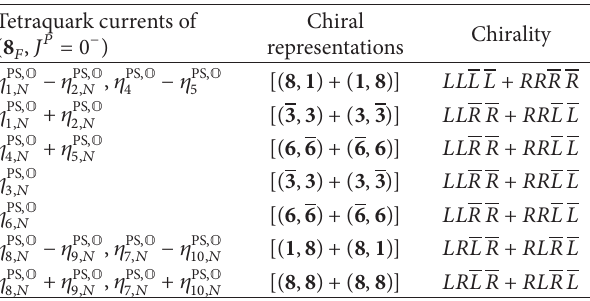
Table 6: Flavor 27 𝐹 tetraquark currents of 𝐽 𝑃 = 0 + classified in